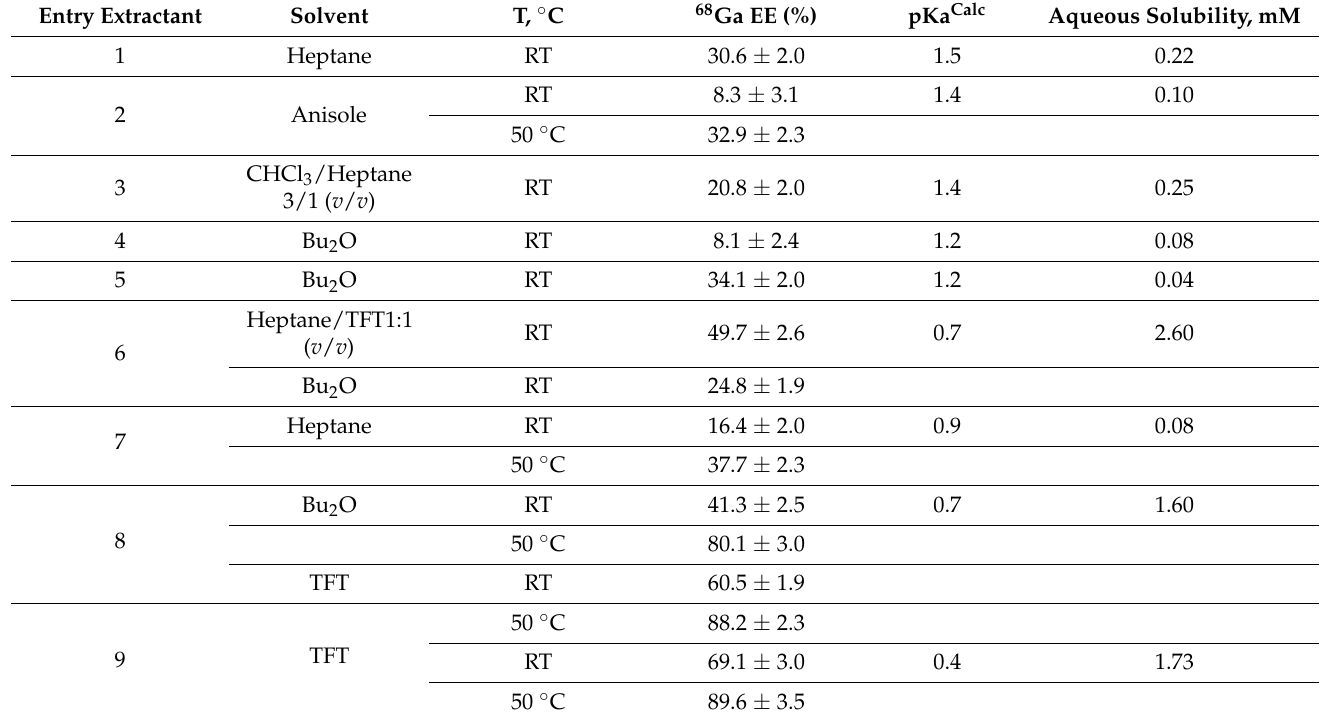
Table 1. Batch LLE of 68 Ga from 1 M zinc nitrate in 0.01 M nitric acid with 10 mM of extractant dissolved in various solvents and performed at RT or 50 ◦ C. The extraction efficiencies (EE), the pKa of the extractants calculated using Cosmotherm, and the experimentally determined aqueous solubilities are listed. Experiments were performed in triplicate; results are presented as means ± standard